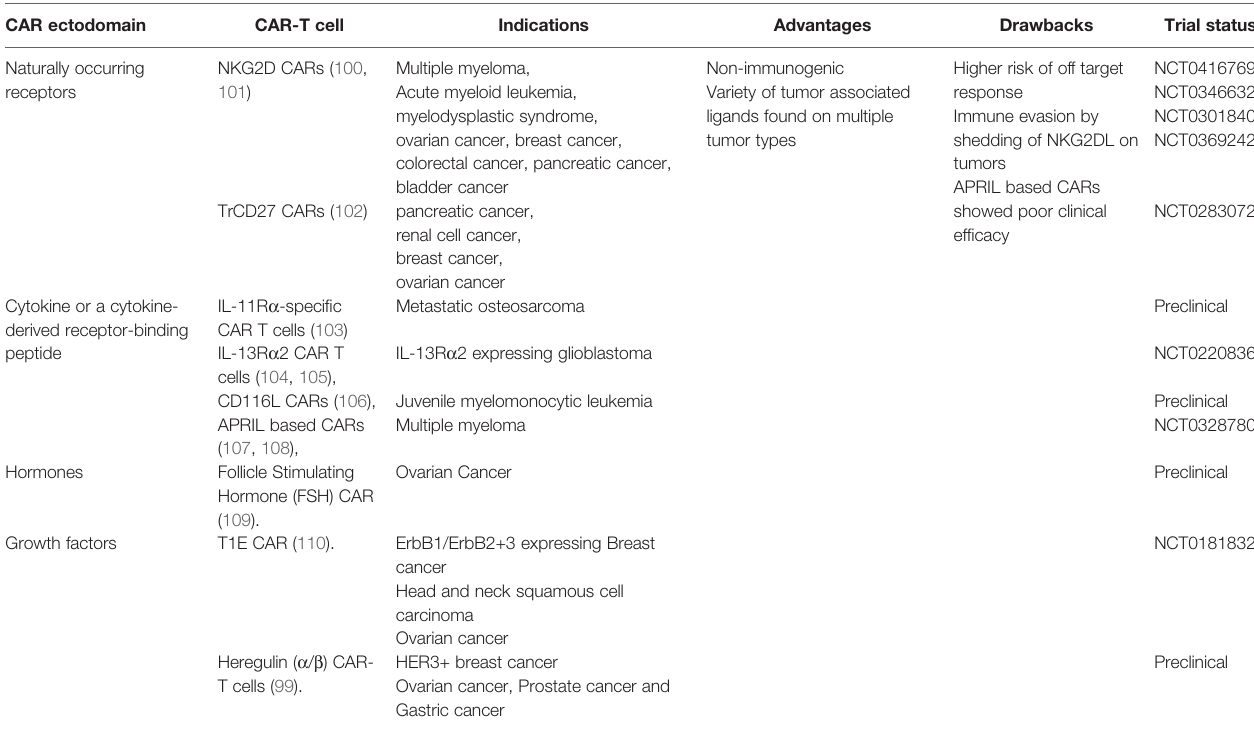
TABLE 1 | Receptor-ligand CAR-T cell strategies in development. CAR-T cell